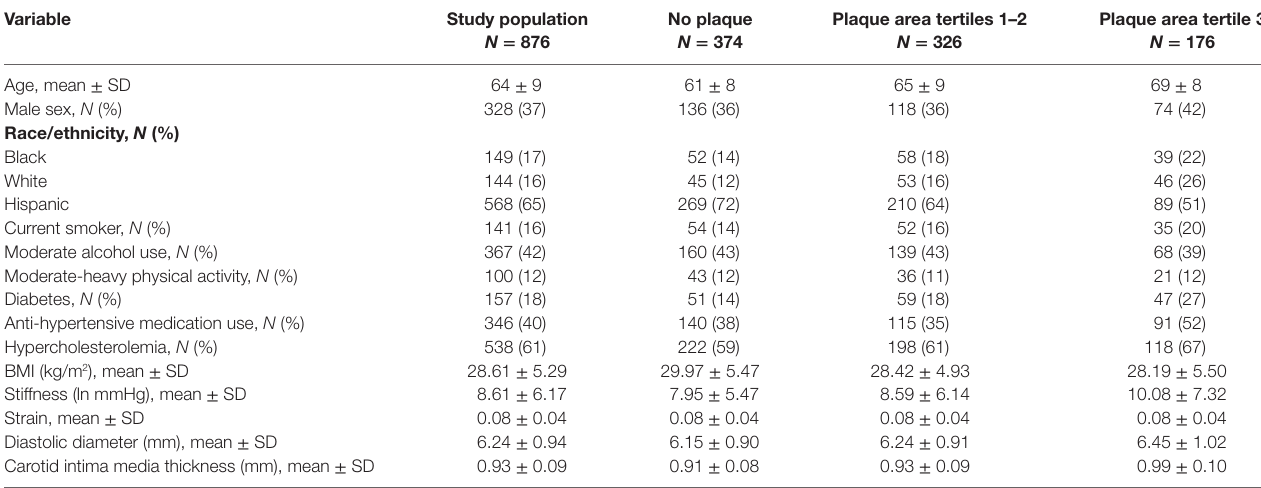
taBLe 1 | Characteristics of the study